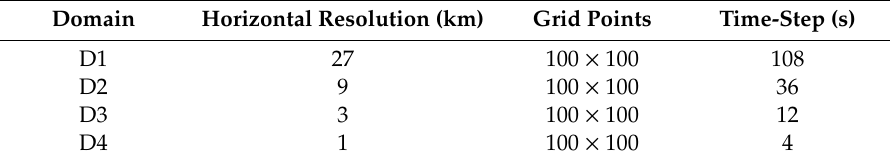
Figure 1. Simulated domain of the Weather Research and Forecasting (WRF) model: ( a ) Scope of the four nested domains (D1~D4) used in the wind simulation; ( b ) Topographic distribution of the innermost domain (D4). The red box represents the computational fluid dynamics (CFD) domain, Table 1. Parameter settings for nested domains (D1~D4).